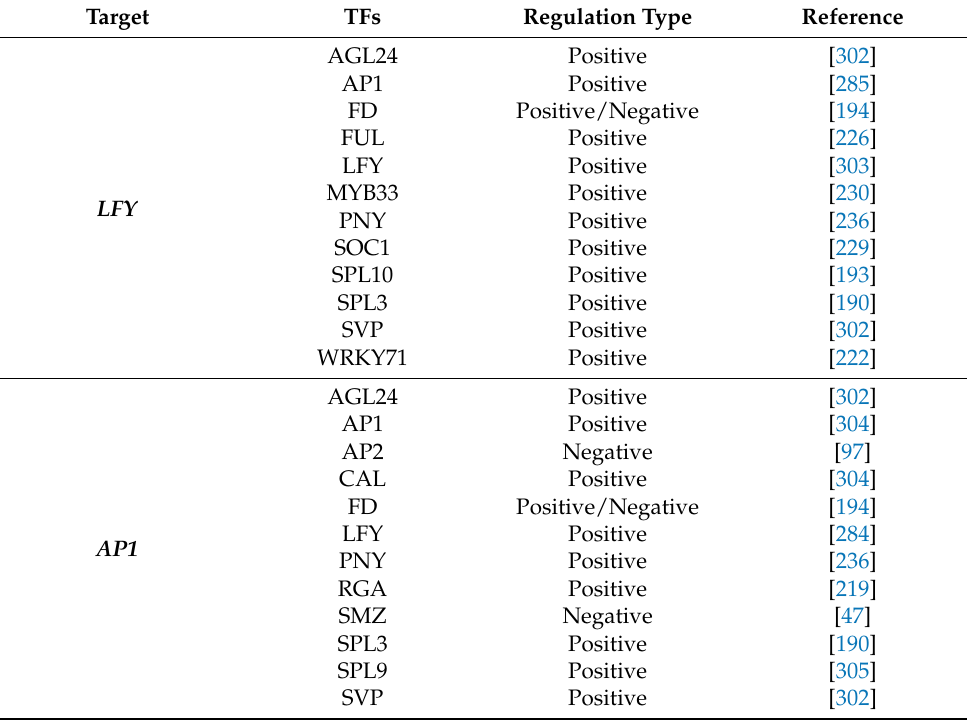
Table 1. Transcriptional factors directly involved in LFY and AP1